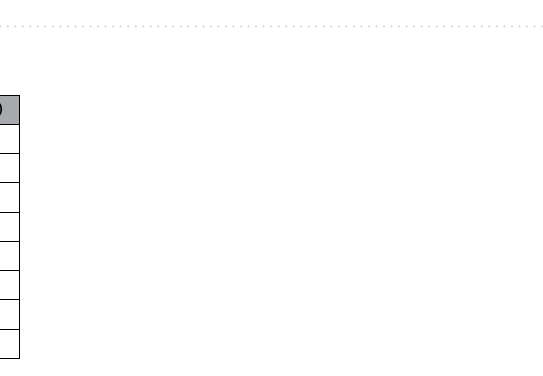
Table 6. Performance comparison of the proposed model with the model using classical convolutions on the UCI-HAR dataset.